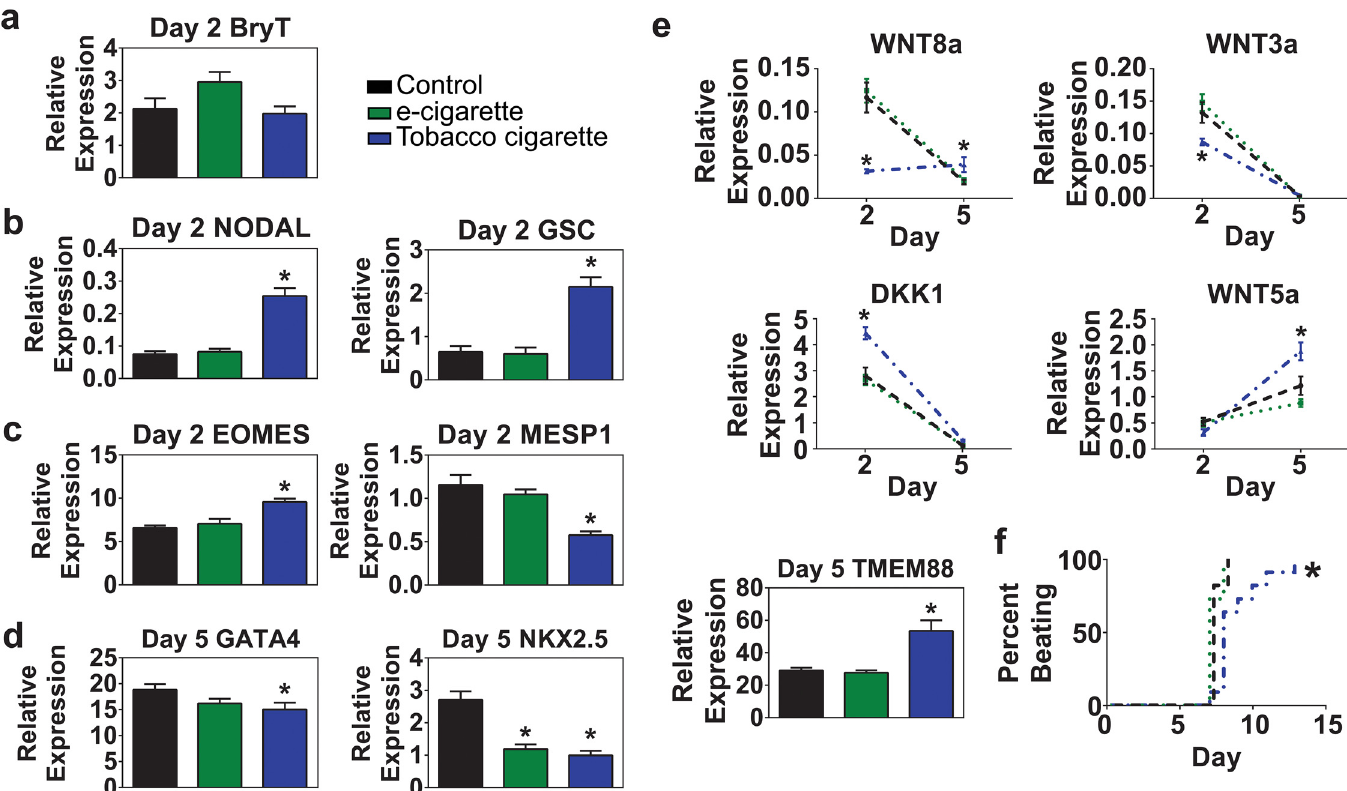
Fig 4. Impact of cigarette exposure on cardiogenic mesoderm development. (a-c) Quantitative RT-PCR analysis of expression levels on day 2 of differentiation for genes involved in mesoderm development following exposure to 6.8 μ M e-cigarette, or tobacco cigarette extract. Analysis included the pan mesendoderm marker Brachyury T (T) (b), mesendoderm genes involved in patterning anterior primitive streak, NODAL and goosecoid (GSC) (c), and cardiogenic mesoderm genes eomesodermin (EOMES) and MESP1. (d) Quantitative RT-PCR analysis of cardiac progenitor cell markers on day 5 of differentiation including GATA4 and NKX2.5. (e) Quantitative RT-PCR analysis of Wnt/ β -catenin ligands WNT3a, WNT8a, WNT5a and Wnt/ β -catenin signaling inhibitors DKK1 and TMEM88 between days 2 and 5 of differentiation. (f) Time course analysis of onset of beating during cardiac differentiation. n (cid:3) 6 per group. * P < 0.05.